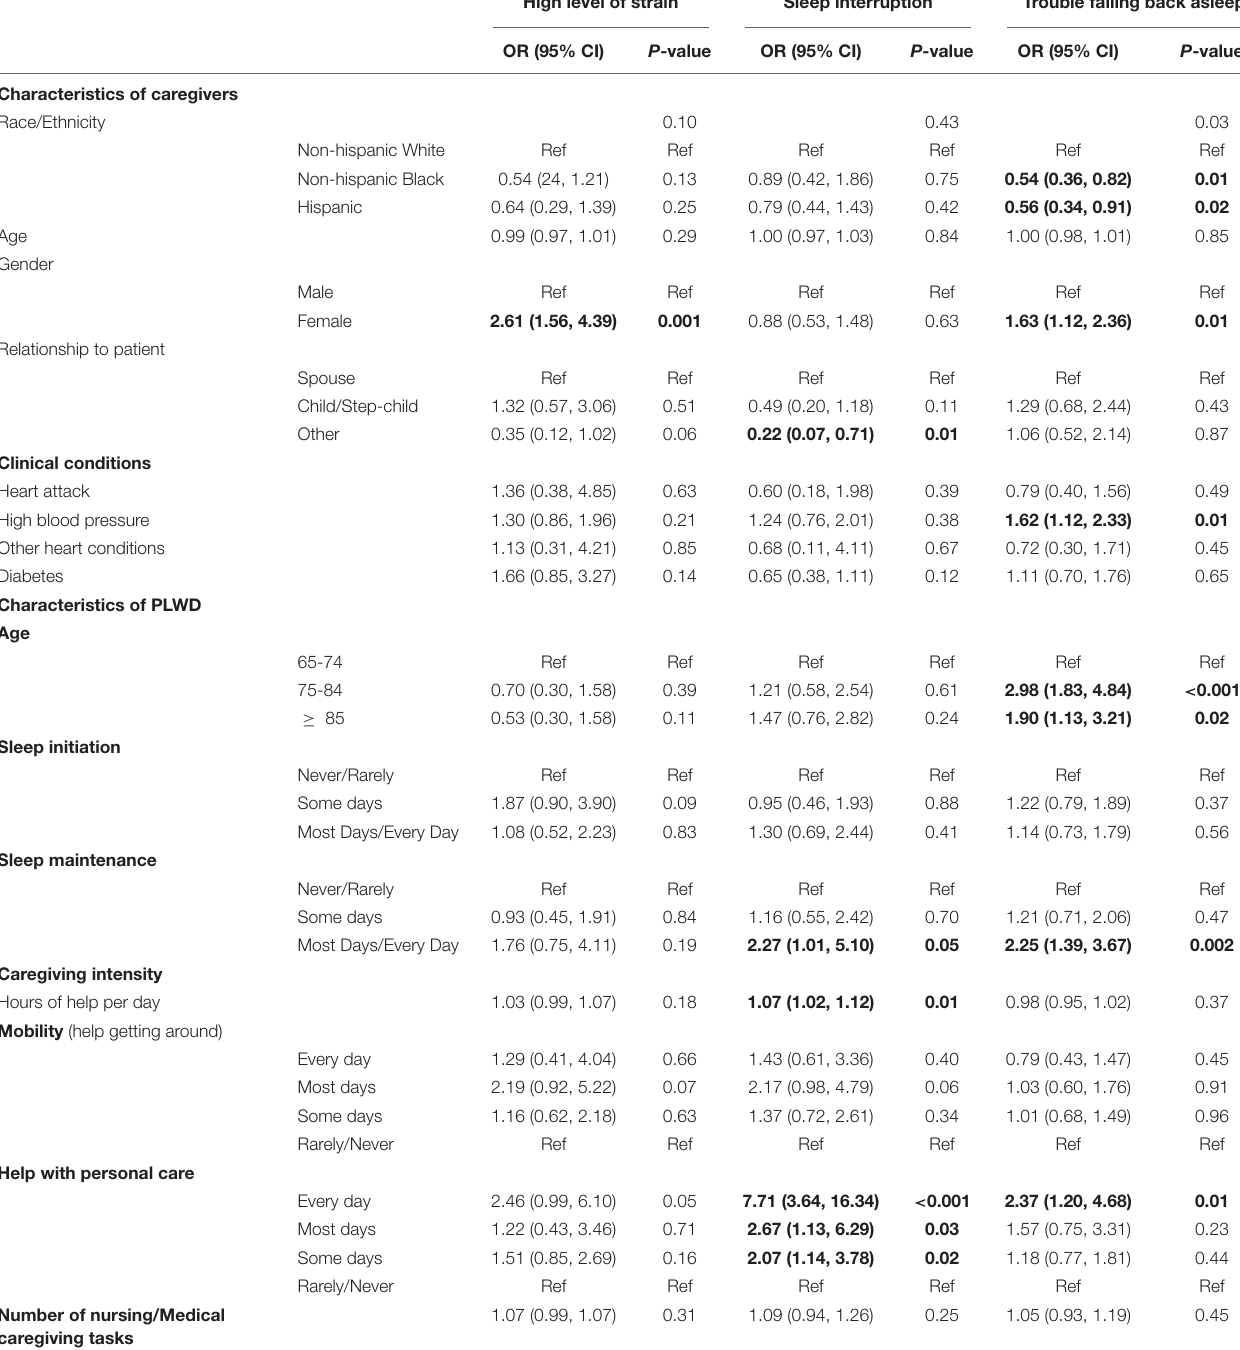
TABLE 2 | Associations between PLWD and caregiver sleep-related disturbances and strain. High level of strain Sleep interruption Trouble falling back asleep OR (95% CI) P -value OR (95% CI) P -value OR (95%